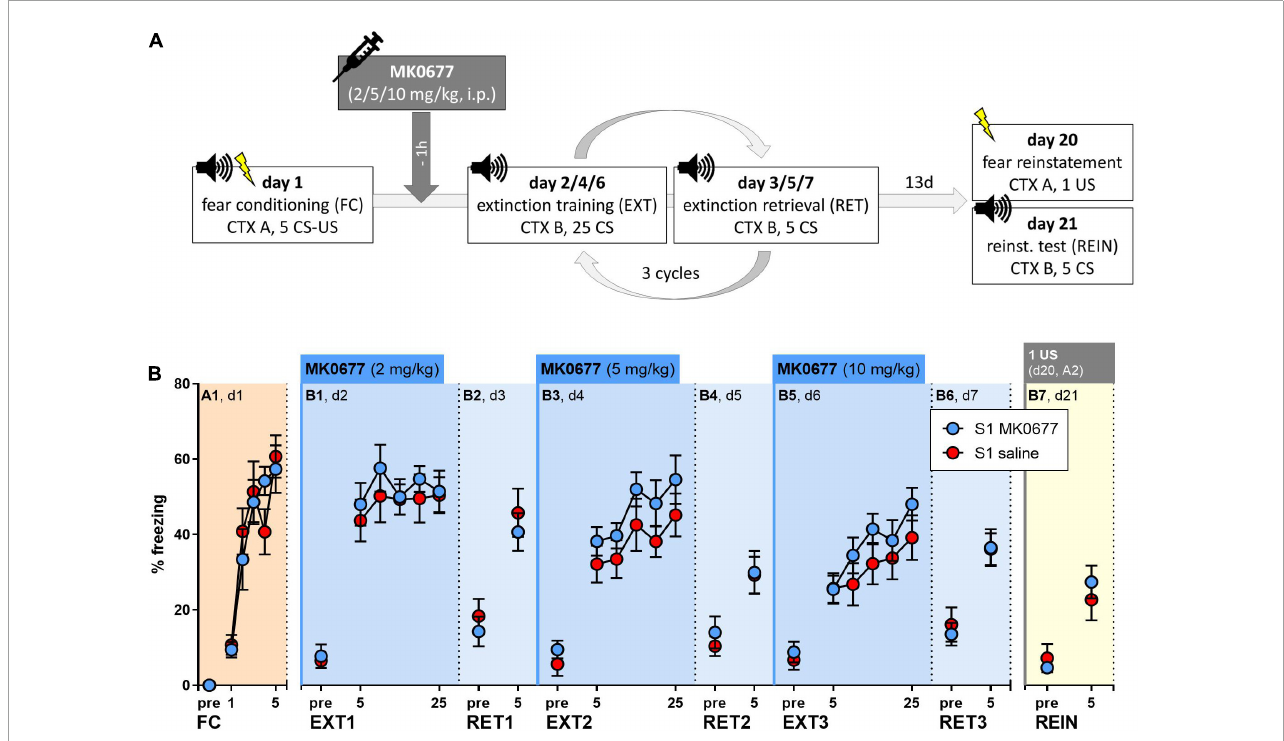
FIGURE3 Effect of pre-extinction training administration of MK0677 intraperitoneally i.p., 2 mg/kg (d2, EXT1), 5 mg/kg (d4, EXT2), or 10 mg/kg (d6, EXT3) on fear extinction in 129S1/SvImJ (S1) mice. (A) Experimental protocol and conditions for all behavioral tests. (B) Percent of time spent freezing during pre-CS periods or indicated CS blocks throughout the experimental paradigm. Both groups showed fear acquisition (FC/A1: “CS block” p < 0.0001, F (3.537, 49.52) = 27.27) and no significant differences during extinction training (EXT1/B1, EXT2/B3, EXT3/B5), extinction retrieval or a fear reinstatement test (RET1/B2, RET2/B4, RET3/B6, REIN/B7). Figure info: S1 MK0677 (blue): n = 8; S1 saline (red): n = 8. All data points represent group means ± SEM for the indicated time periods (pre-CS, single CS, or 5-CS average blocks). FC, fear conditioning; EXT, extinction training; RET, extinction retrieval; REIN, fear reinstatement test; US, unconditioned stimulus; CS, conditioned stimulus; pre, pre-CS